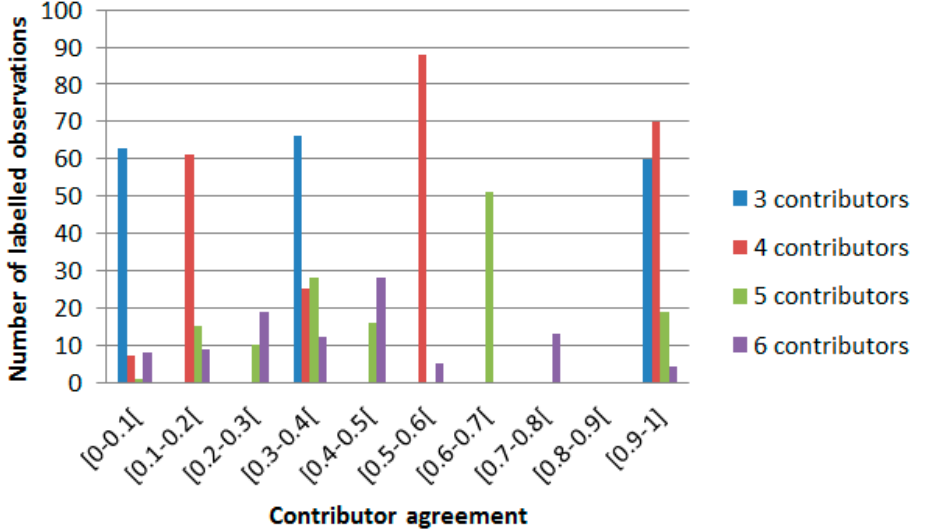
Figure 9. Frequency of the degree of agreement for all changes.